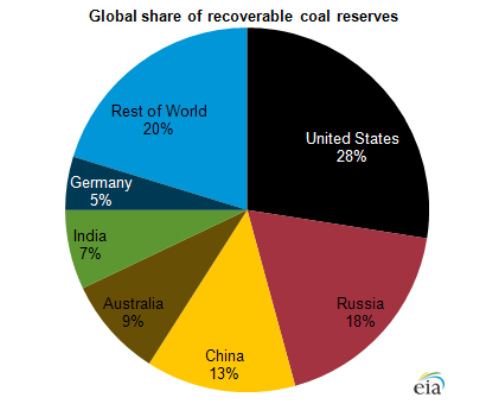
Figure 3. World coal reserves in 2011 in leading countries [3].